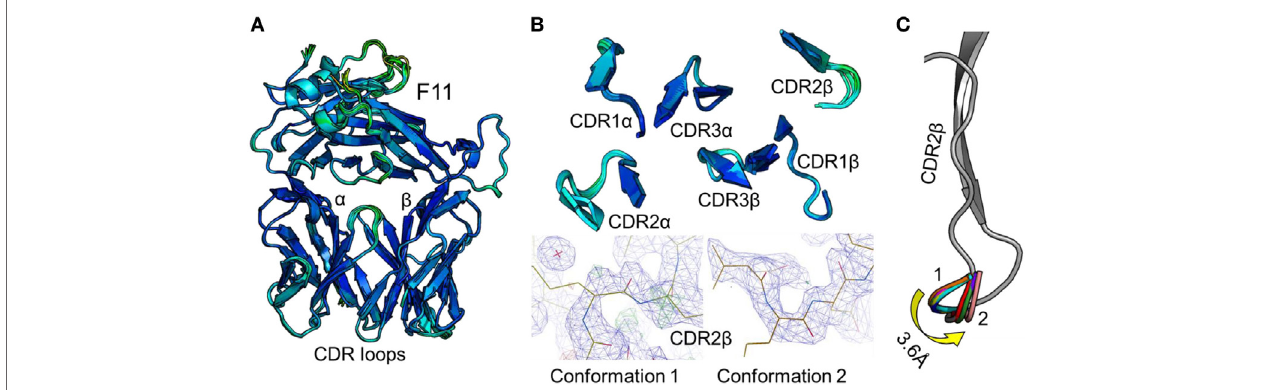
FigUre 1 | Comparison of 12 unbound structures of the F11 T cell receptor (TCR). (a) Side-on view of the overall conformation of the F11 TCR (cartoon, colored by B-factor) including alignment of structures generated from 12 different crystals. (b) Top down view of an alignment of the complementarity determining region (CDR) loops (cartoon, colored by B-factor) from the 12 structures of unbound F11 TCR. The panels below demonstrate the two extreme conformations (conformation 1 and 2) of the CDR2 β loop from the different structures, with the observed electron density map at 1 σ . (c) Side-on view of the F11 TCR CDR2 β loop (framework region in gray, apex of the loop in multiple colors) aligning all 12 structures with conformation 1 and conformation 2 labeled.